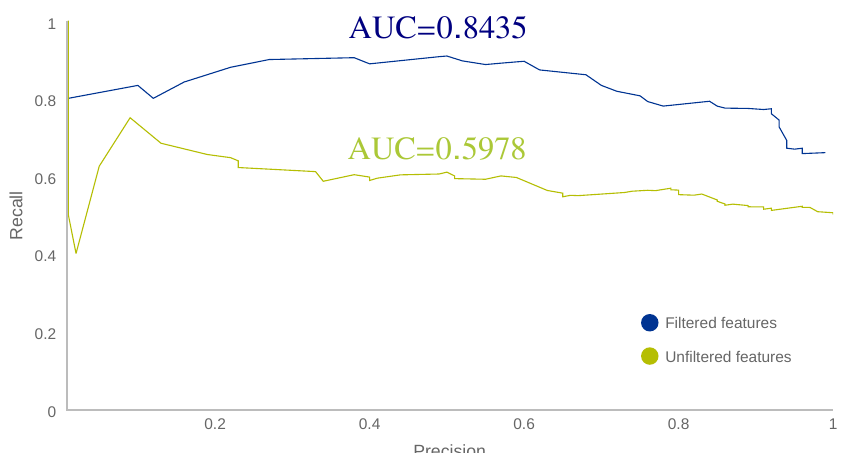
Figure 3. Area under the curve (AUC) of our model trained with both the initial and selected set of features.